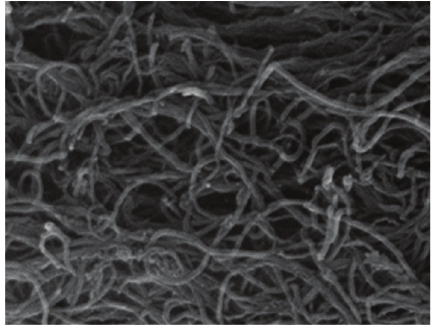
Figure 1: SEM image of the